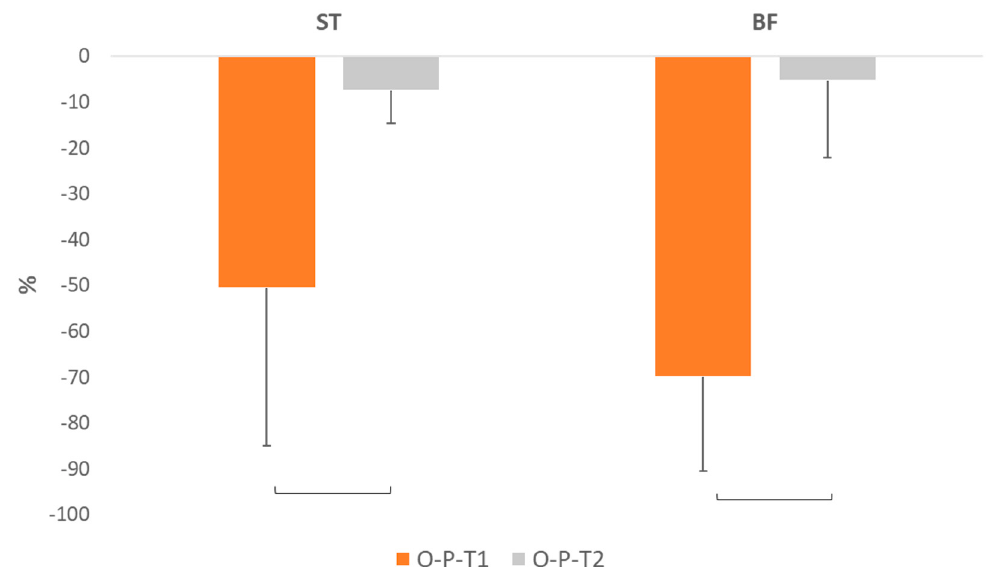
Figure 7. Percentage changes in the area under the curve of semitendinosus (ST) and biceps femoris (BF) EMG activity corresponding to the K5 power burst across the early perturbation of obstacle to platform (O-P-T1, orange) and late perturbation (O-P-T2, gray) conditions.